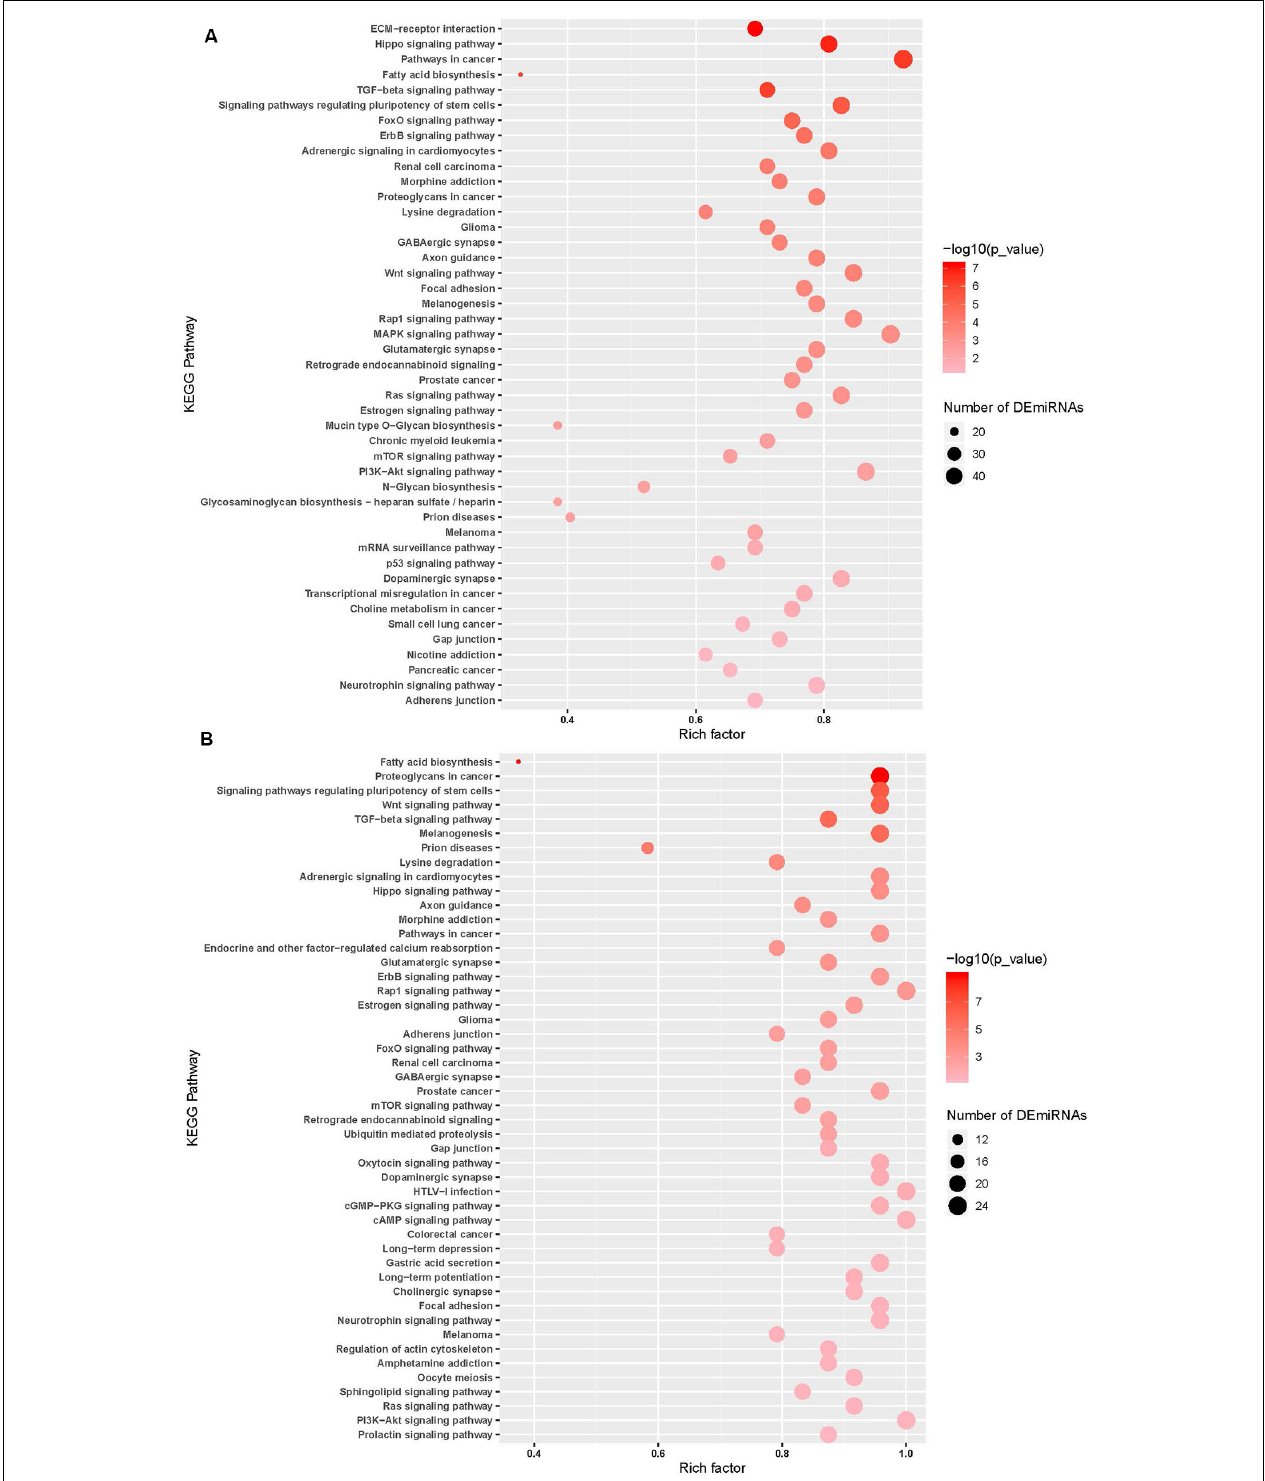
FIGURE 5 | miRNA pathway analysis of the top enriched miRNAs. Predicted gene targets and associated KEGG pathways following pathway analysis of the top ∆ NLS-TDP43 (A) and WT-TDP43 (B) miRNAs using mirPath v.3. Higher intensity of red shading reflects increasing significance values, while the size of the nodes represents the number of altered miRNAs within the pathway. Lists of the predicted pathways represented among the ∆ NLS-TDP43 and WT-TDP43 enriched miRNAs are also detailed in Supplementary Tables S1, S2 .